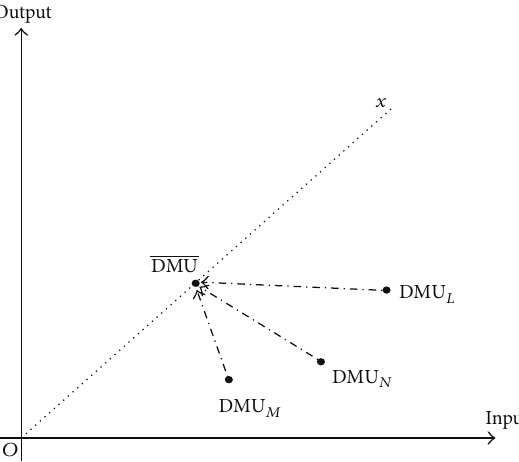
Figure 1: An illustration of the model for gap analysis, showing DMUs below the virtual ideal